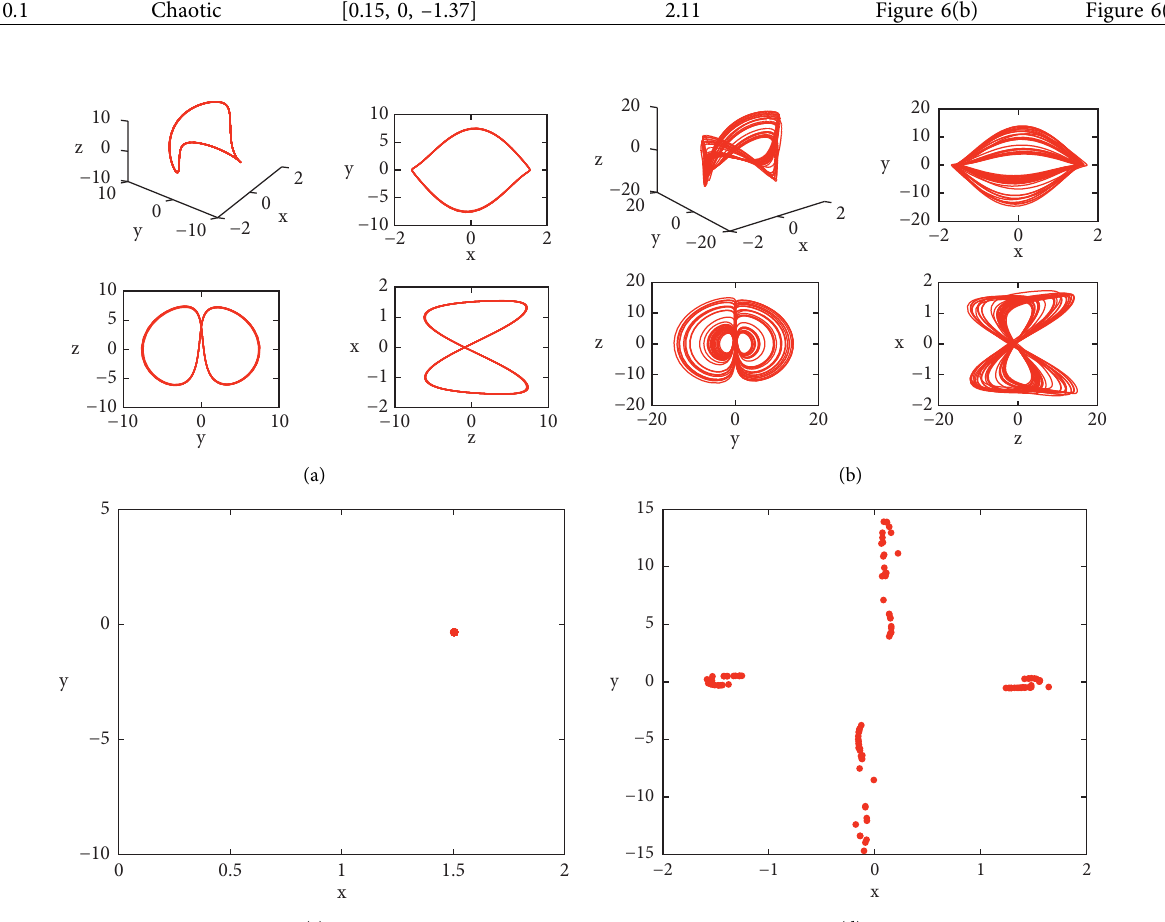
Figure 5: Phase portraits and Poincar´e section of system (1) in plane z � 0 for some special values of parameter a with constant parameters b, c, and e . (a) Periodic orbit and projection in x-y plane, y-z plane, and z-x plane. (b) Chaotic attractor and projection in x-y plane, y-z plane, and z-x plane. (c) Poincar´e section in plane z � 0. (d) Poincar´e section in plane z �